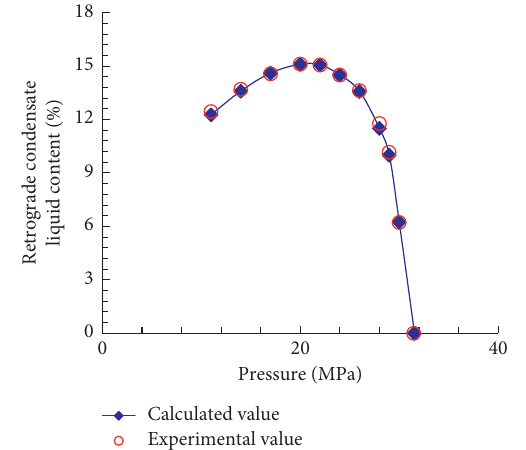
Figure 11: Comparison for sample 3 of calculated and experi- mental relationship diagram between retrograde condensate liquid volume and pressure.